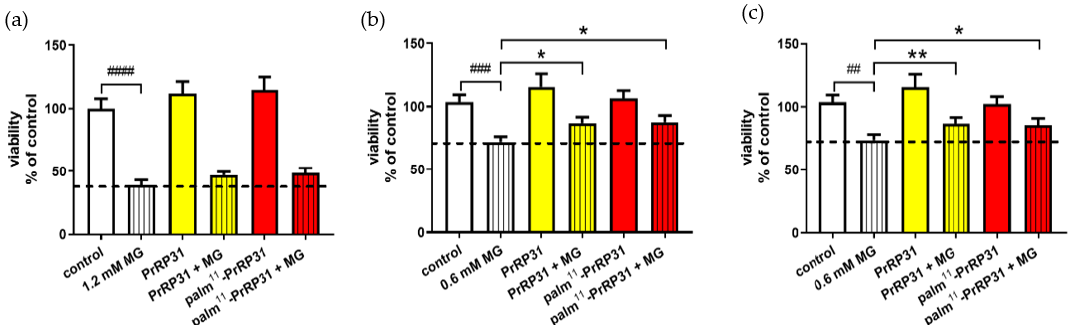
Figure 6. PrRP31 increased cell viability of SH-SY5Y cells after 16-h exposure to MG. Treatment for 4 h with PrRP31 and palm 11 -PrRP31 at a concentration of: ( a ) 1 × 10 − 5 M; after exposure to 1.2 mM MG for 16 h in SH-SY5Y cells. Treatment for 4 h with PrRP31 and palm 11 -PrRP31 at a concentration of: ( b ) 1 × 10 − 5 M; ( c ) 1 × 10 − 7 M, after exposure to 0.6 mM MG for 16 h in SH-SY5Y cells. MG toxicity measured with MTT assay. Data are presented as the means ± SEM as a percentage of control cells treated with vehicle analyzed by a Student´s t -test vs. 0.6 mM MG ## p < 0.01, ### p < 0.001, #### p < 0.0001 ( n = 3, each sample in octuplicates). Control vs. 0.6 mM MG analyzed by a Student´s t -test, * p < 0.5, ** p < 0.01.